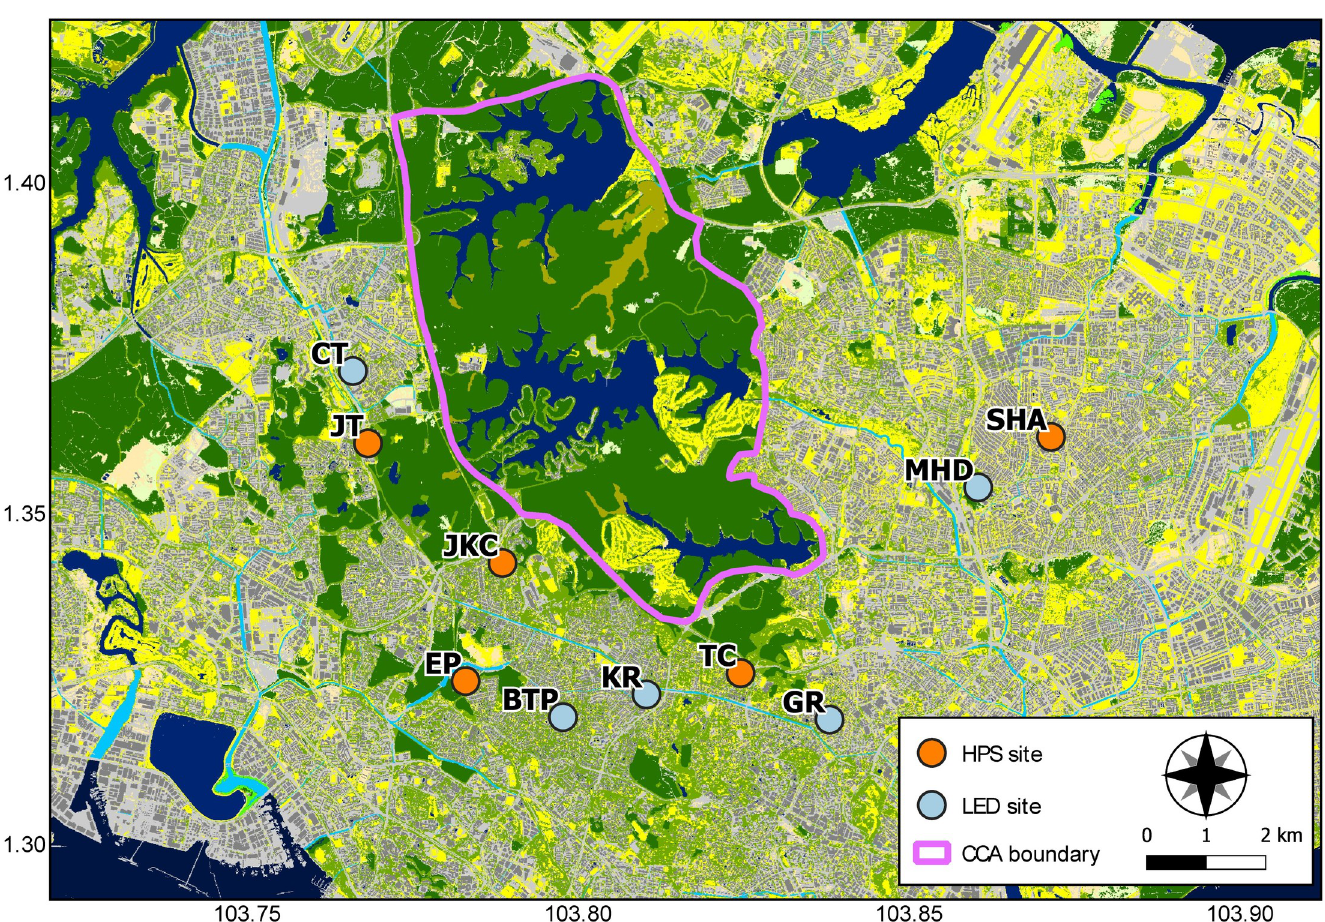
Fig 1. Location of HPS (control) and LED (treatment) streets. Base map taken from Gaw et al. [40]. Polygon delineates the boundary of the Central Catchment Area.